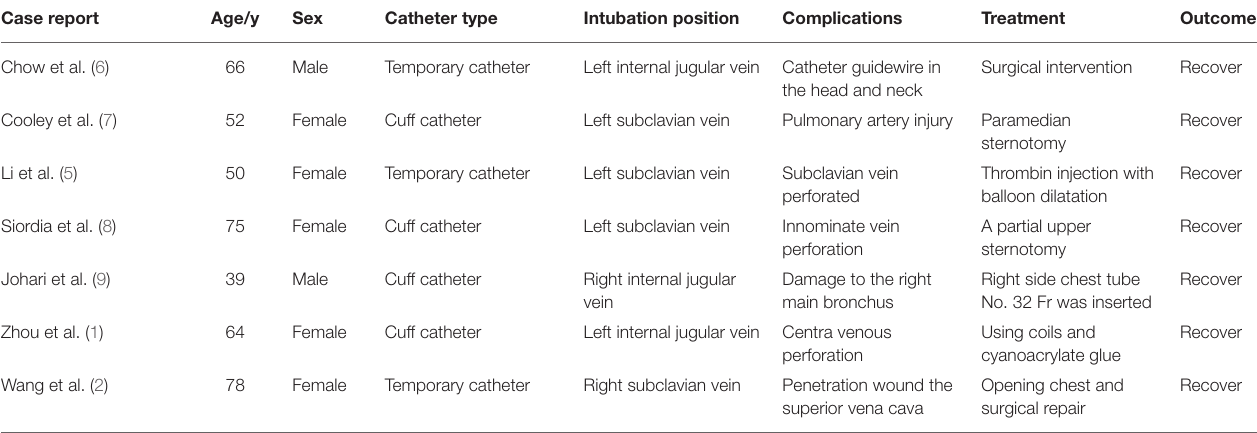
TABLE 1 | The related literatures of venous perforation during the hemodialysis catheter placement ( n = 7). Case